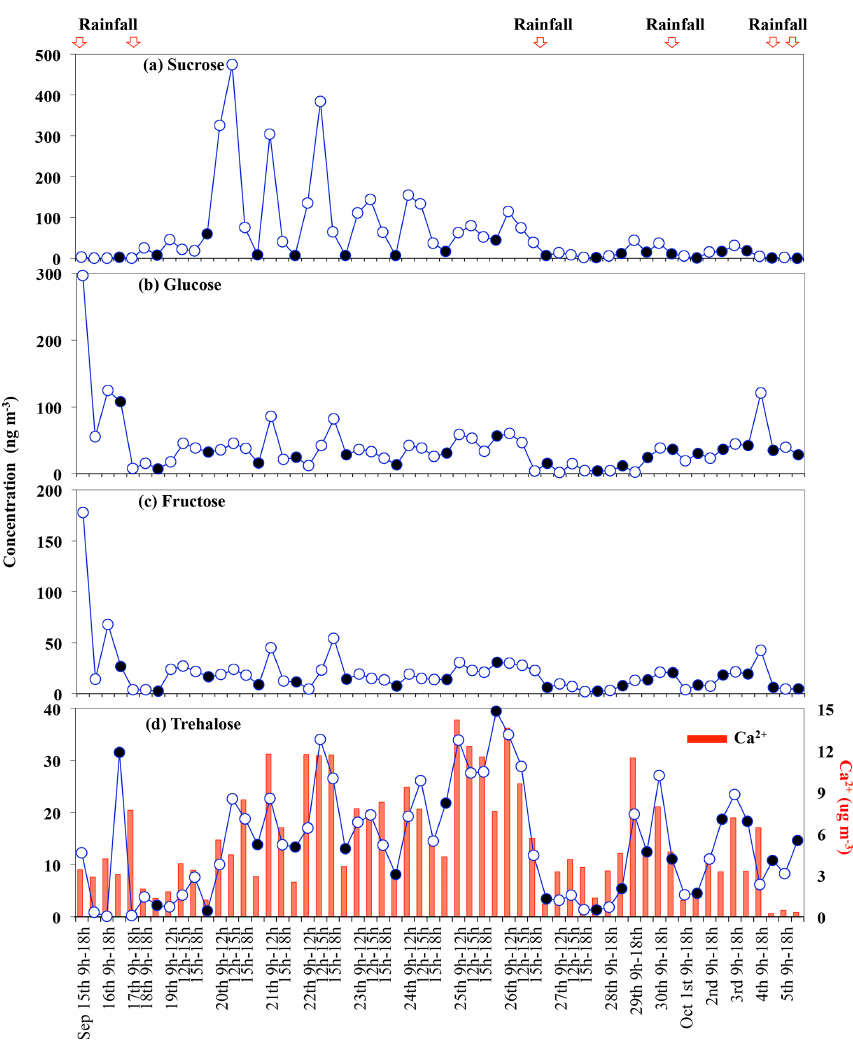
Figure 5. Temporal variations in the concentrations (ngm − 3 ) of primary sugars in the Mangshan aerosol samples collected for September– October 2007 (solid circle represents nighttime samples collected from 18:00 to 09:00; hollow circle represents daytime samples). The y axis shows temporal variations in the concentrations (µgm − 3 ) of Ca 2 +